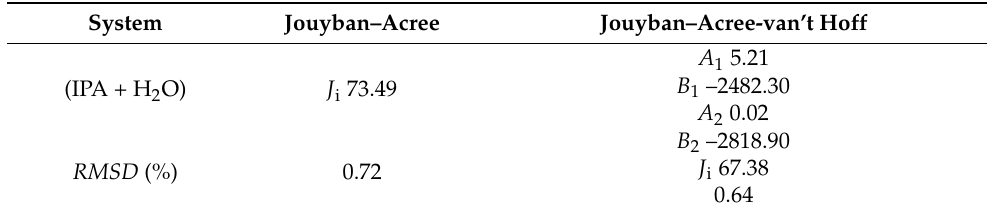
Table 9. An average RMSD for the JAM model was predicted as 0.72%. Table 9. Resulting data of Jouyban–Acree and Jouyban–Acree–van’t Hoff models for TQ in (IPA + H 2 O)